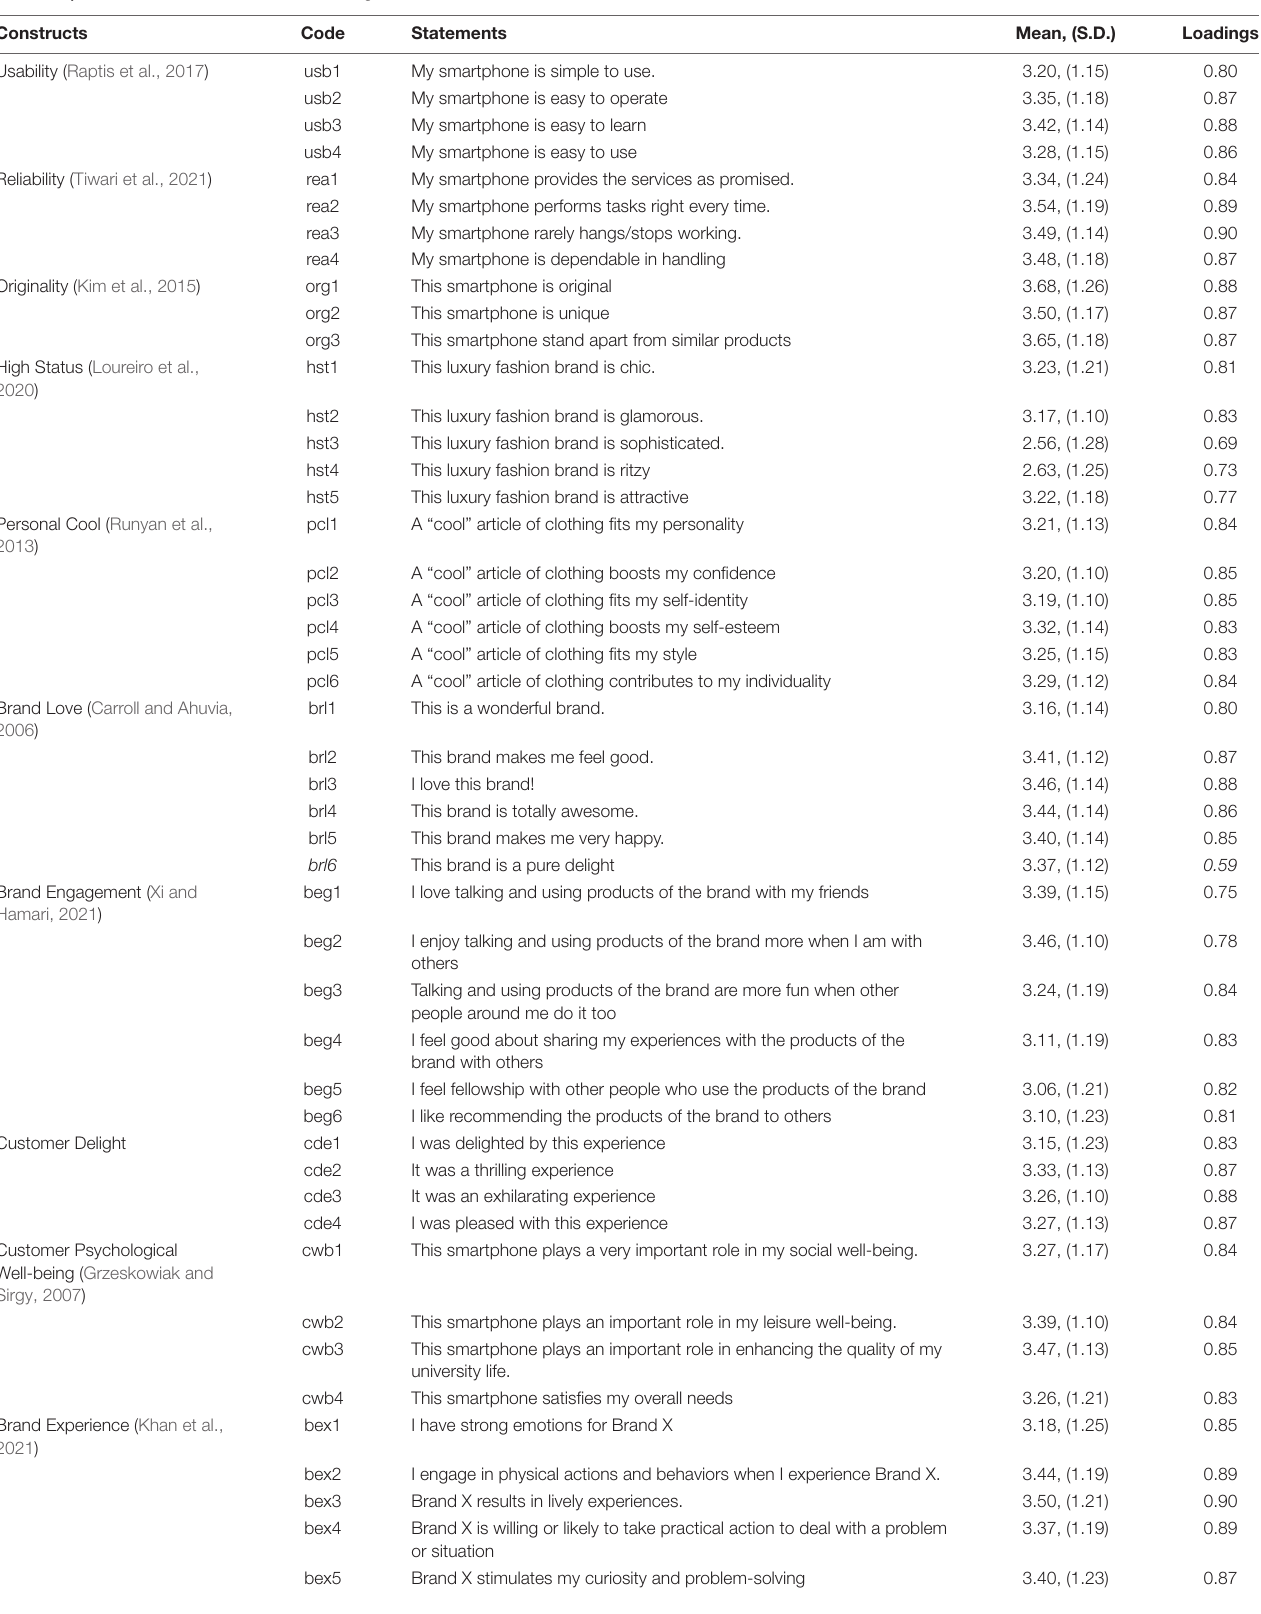
TABLE 2 | Measurement scales with outer